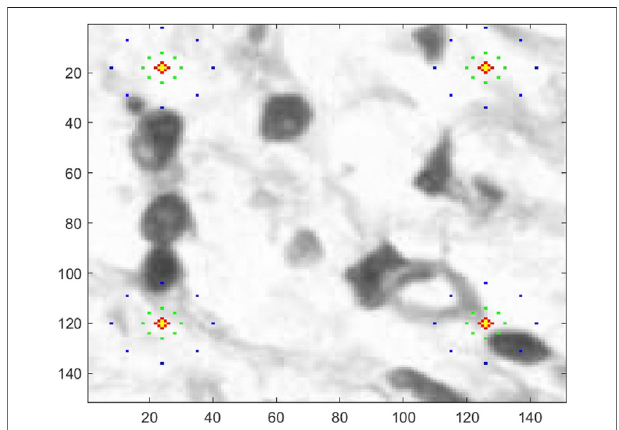
FIGURE 6 | Detail of a slide with examples of grid based instances.